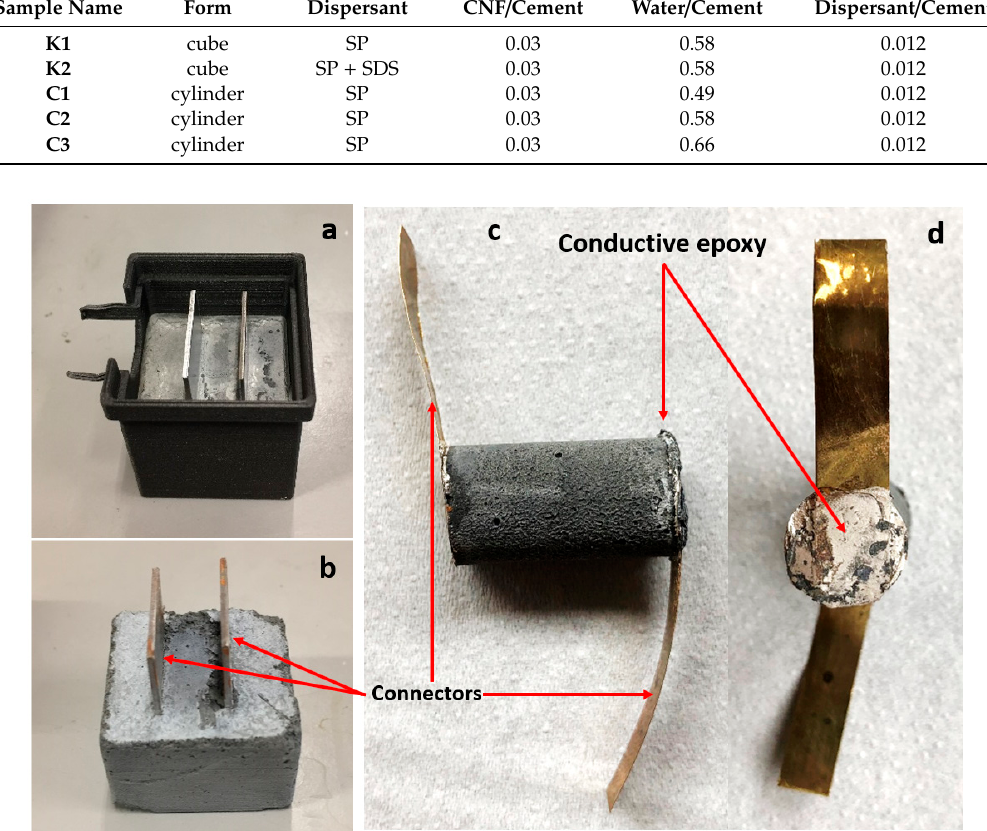
Figure 1. Photography of sample K in a 3D printed mold before ( a ) and after ( b ) removal from the mold, and sample C, side view ( c ) and top view ( d ), indicating metal connectors. Note, the connectors are embedded inside the hardened cement in samples K whereas the connectors are glued to the sides in samples C.